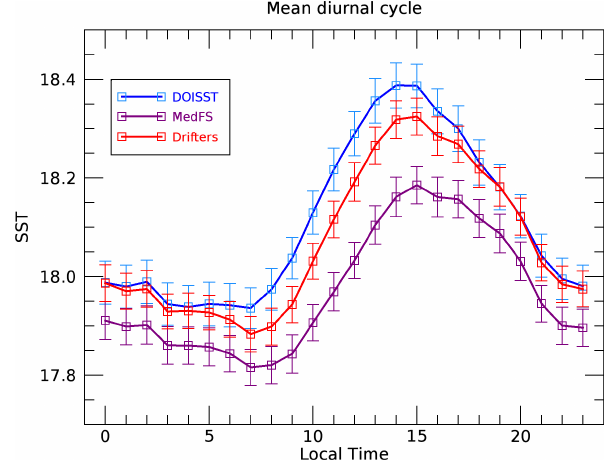
Figure 4. Mean diurnal cycle for MED DOISST (blue line), MedFS (purple line), and drifters (red line) computed over the matchups from 2019 to 2020.